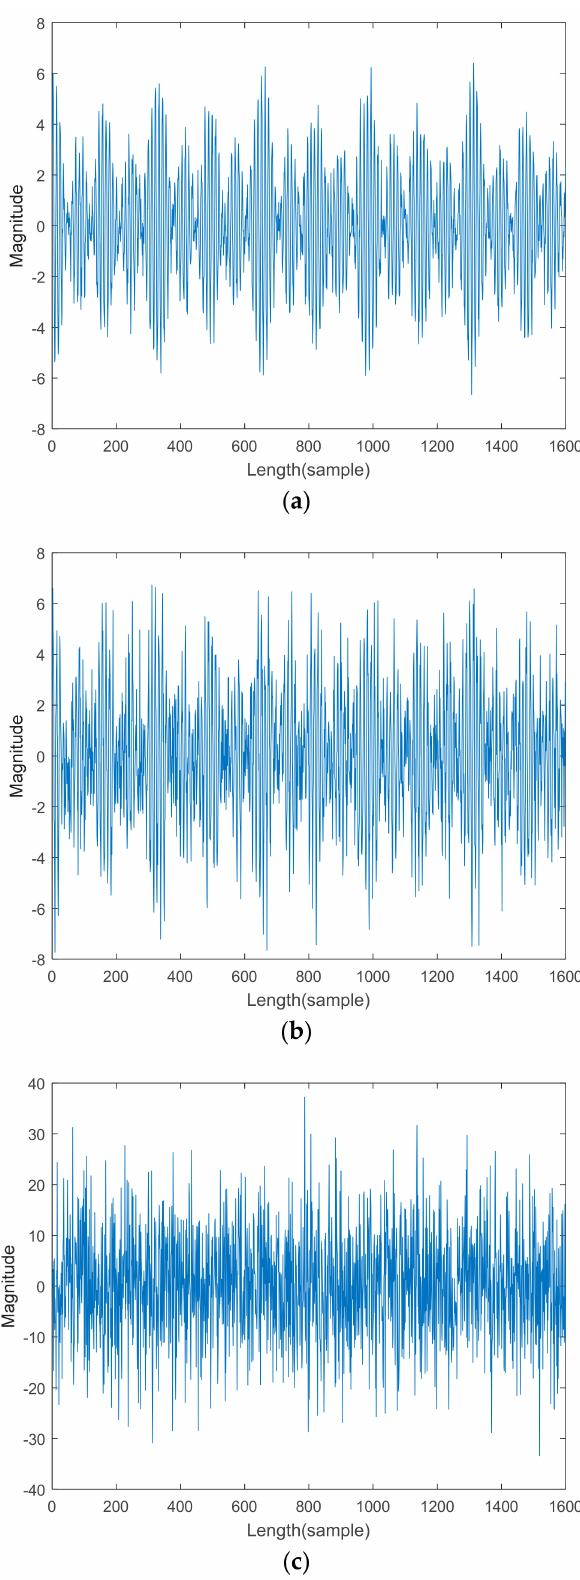
Figure 5. The input of time domain multi-tone signals with different SNRs. ( a ) SNR = 12 dB; ( b ) SNR = 6 dB; ( c ) SNR = 0